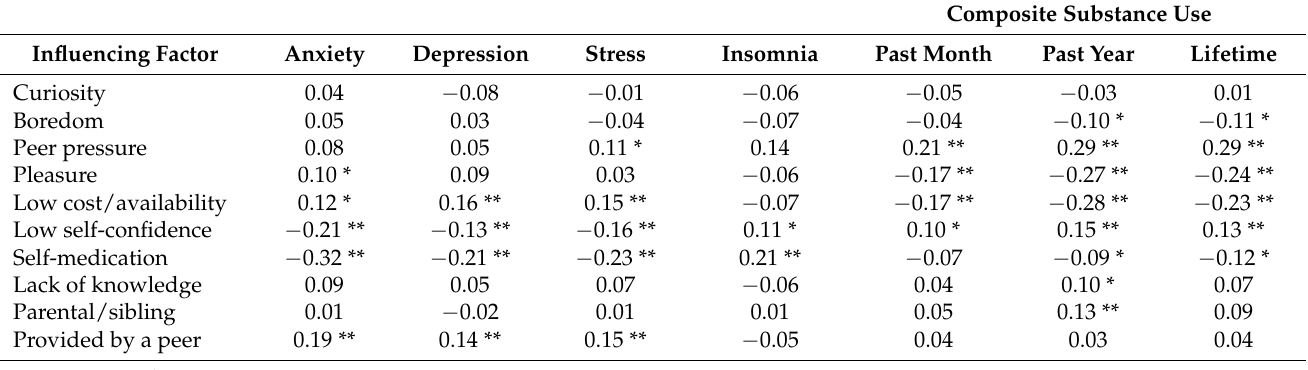
Table 3. Correlational associations between cited reasons for substance use and symptoms of anxiety, depression, perceived stress, and